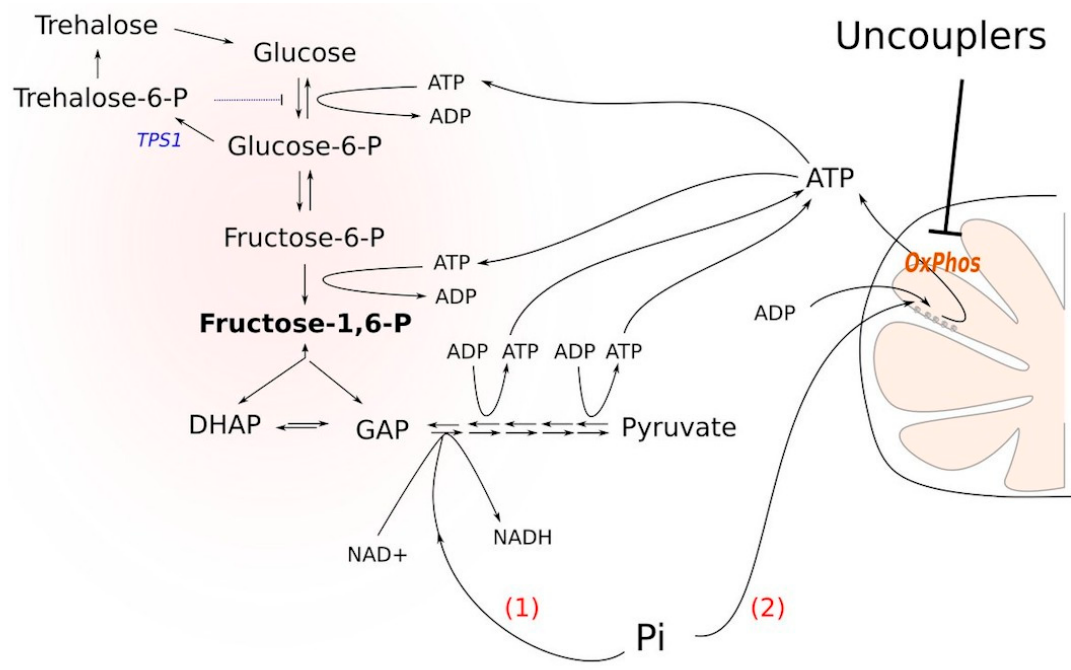
Figure 1. Two routes of inorganic phosphate entry into cell catabolism under glycolysis-overflow conditions induced by TPS1 deletion. (1) Glyceraldehyde dehydrogenase reaction consumes Pi and induces upstream fructose-1,6-bisphosphate processing. This route is expected to alleviate glycolytic block. (2) ATP synthesis via oxidative phosphorylation (OxPhos) consumes Pi; this route can aggravate glycolytic block because ATP contributes to the carbohydrate phosphorylation in the upper glycolysis and drives the synthesis of fructose-1,6-bisphosphate. Uncouplers inhibit the second pathway and, therefore, may increase the assimilation of Pi via the first route.